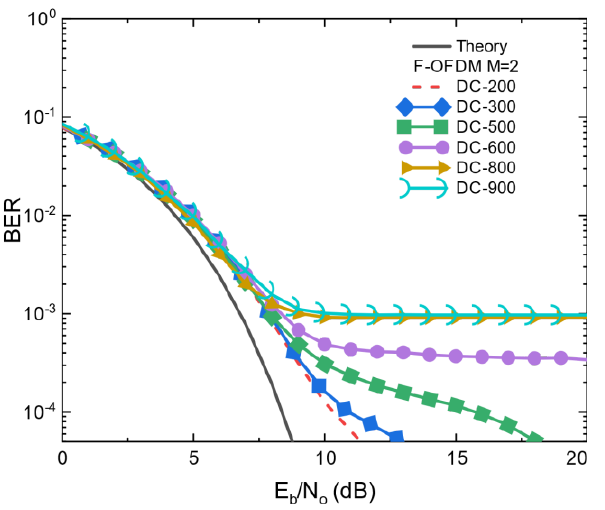
b /N o for OFDM with 4-QAM and 600 AC.